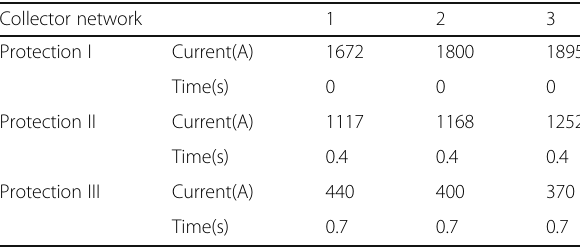
Table 2 Three-section current protection setting of the collector network Collector network